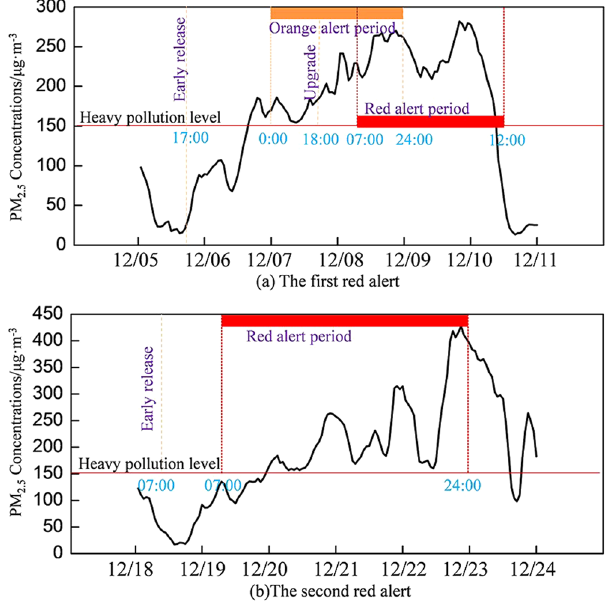
Figure 1. Temporal variations of hourly averaged PM 2.5 concentrations at 35 stations in Beijing during two red